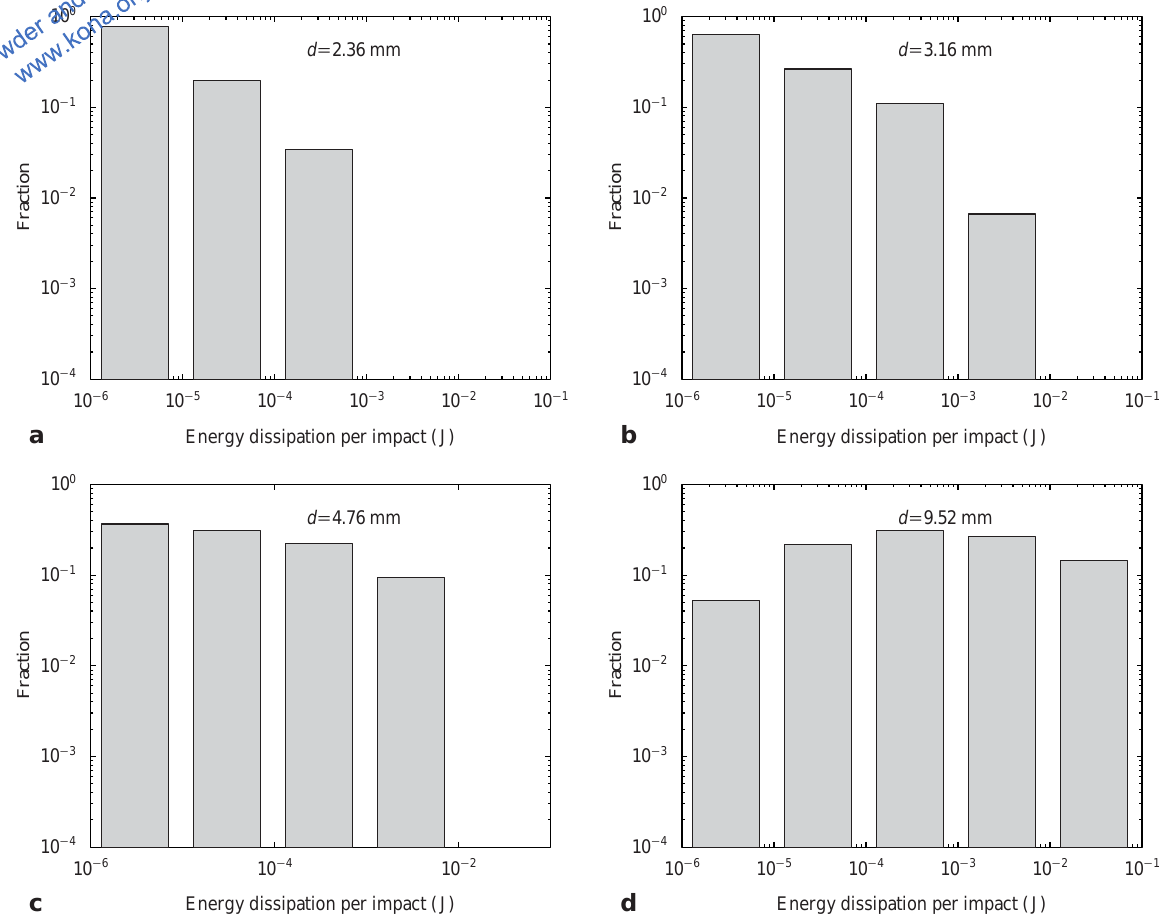
Fig. 2 Histograms of the fraction of energy dissipation per impact for different impact energies for the systems with different ball diameters, d : a. d (cid:3) 2.36 mm; b. d (cid:3) 3.16 mm; c. d (cid:3) 4.76 mm, and d. d (cid:3) 9.52